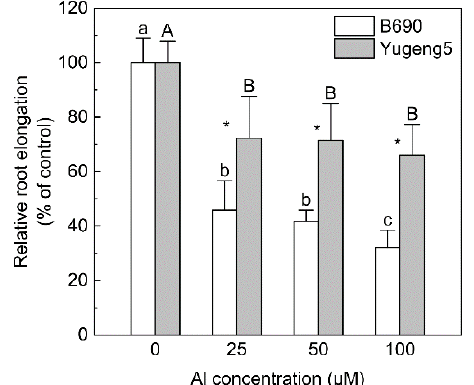
Figure 1. Comparison of aluminum (Al) tolerance between two rice cultivars, ‘B690’ and ‘Yugeng5’. Two-day-old rice seedlings were exposed to 0.5 mM CaCl 2 solution (pH 4.9) containing 0, 25, 50 or 100 µ M Al for 24 h. Relative root elongation (%) is the ratio of root elongation with Al to root elongation without Al. Di ff erent lowercase and capital letters above bars indicate significant di ff erences among di ff erent Al concentrations for the same rice cultivar ( p < 0.05, Duncan’s multiple range test). Asterisks indicate significant di ff erences between the two rice cultivars at the same Al concentration ( p < 0.05, independent-sample t test).